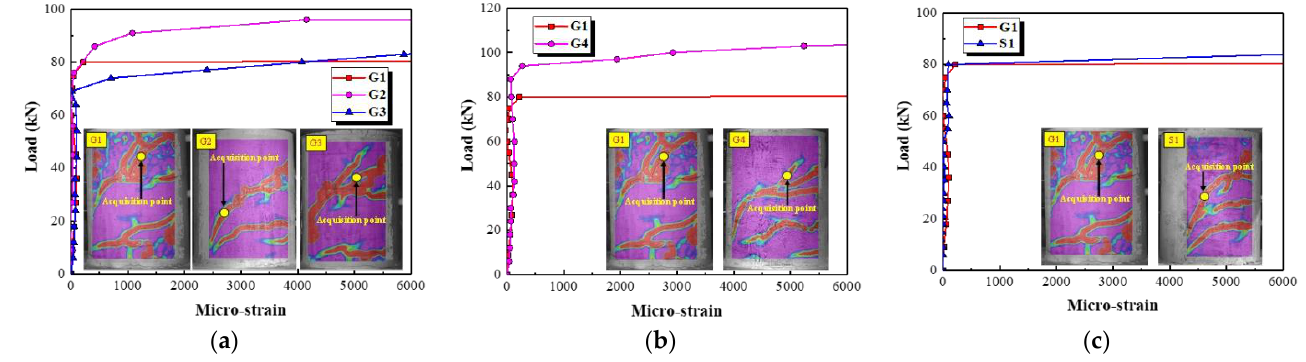
Figure 15. The effect of different parameters on the concrete strain. ( a ) Stirrup reinforcement ratio; ( b ) Longitudinal reinforcement ratio; ( c ) Type of stirrups.